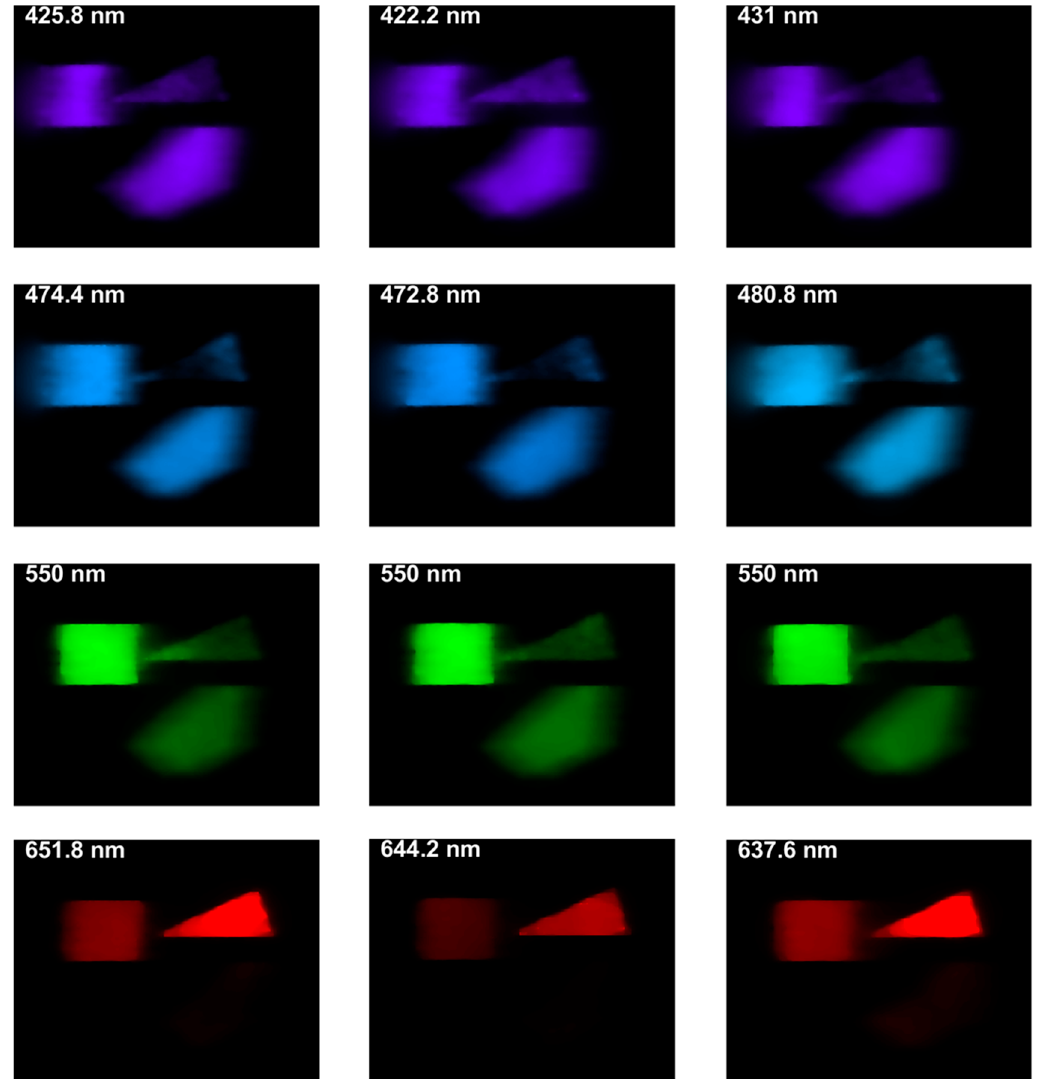
Figure 17. The spectral characteristic of the targets when the dual prism displacement is in Gap 1 ( first column ), Gap 2 ( middle column ) and Gap 3 ( Right column ) for four different wavelengths. Note the subtle intensity change of the colors across the rows. The images are presented using the CIE 1964 color scheme.